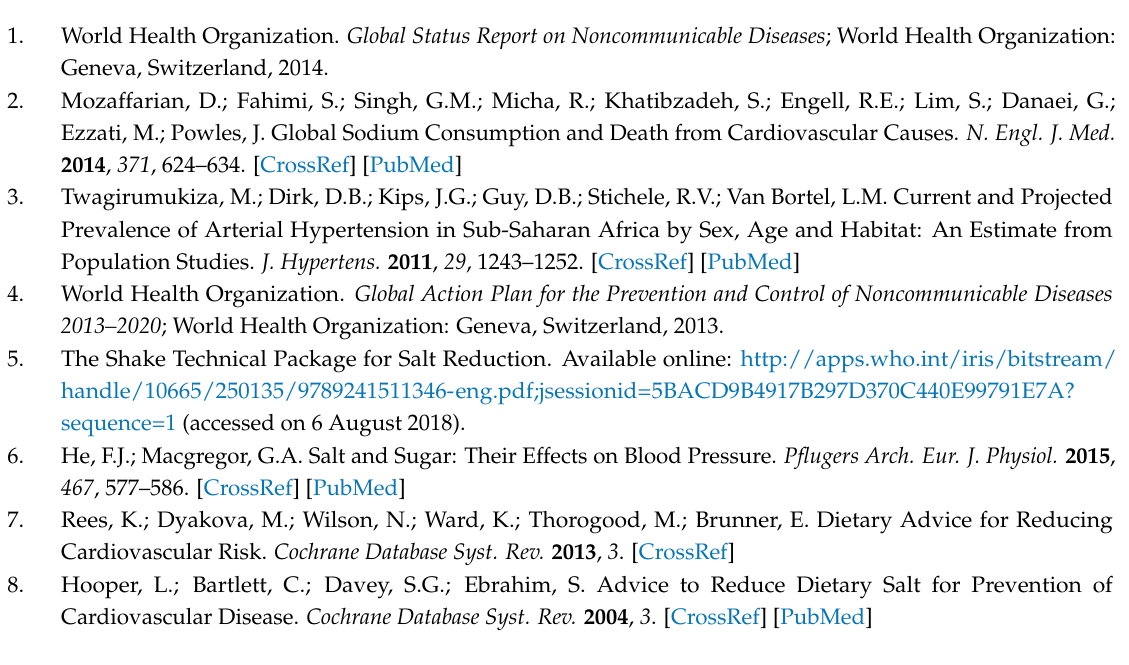
s1, Table S1: Knowledge, attitudes, and practices related to salt intake according to sex, age, education, and hypertension